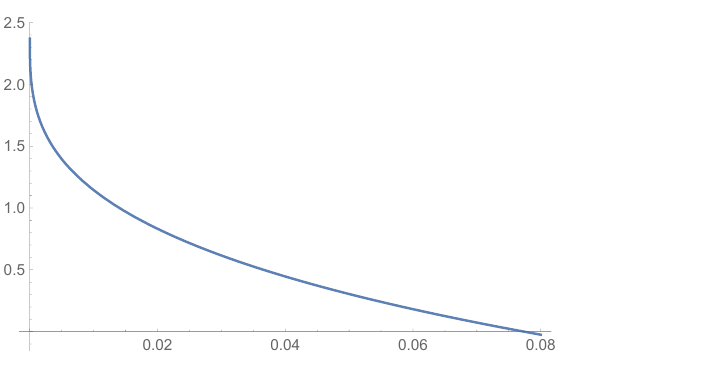
− 2 δ (cid:48) , for β = 0, . . . β β